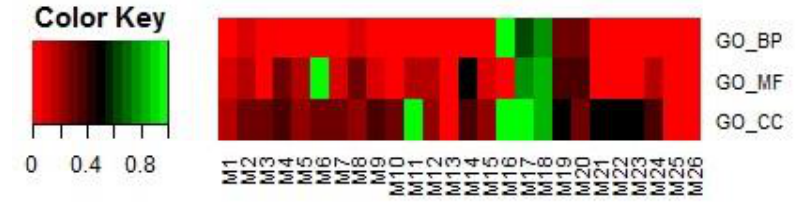
Figure 9. Proportions of the numbers of common terms between each of the 26 selected modules and TSA targets among the total number of terms related to the module. Terms included BPs, MFs, and CCs.